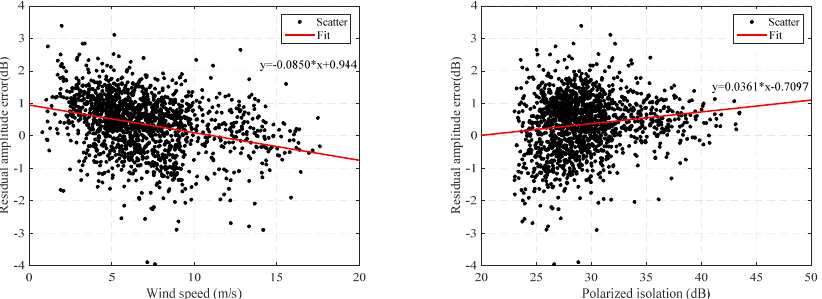
Figure 11. The residual amplitude error variation relative to wind speed and polarization isolation.